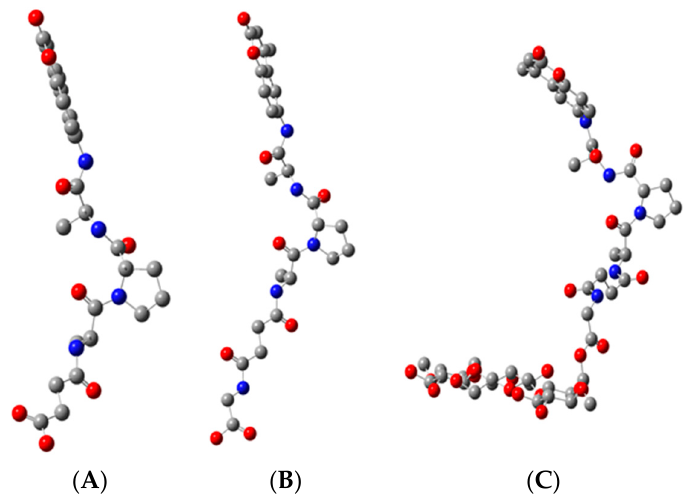
Figure 3 . Minimum energy conformations of the tripeptide (Suc-Ala-Pro-Ala-AMC) ( A ) tripeptide coupled to glycine ( B ) and the tripeptide anchored onto glycinated cellotriose ( C ).